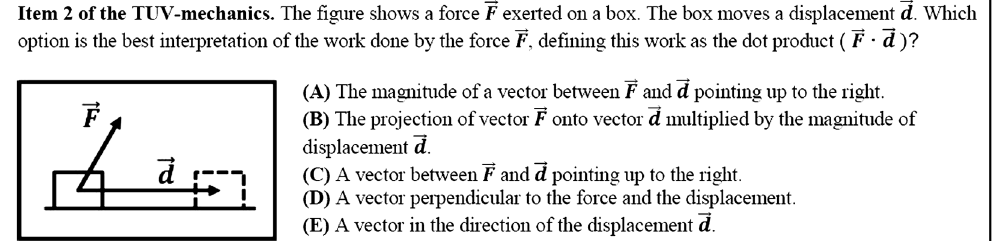
FIG 1. Item 2 of the TUV-12 items no context and the TUV-12 items mechanics that evaluate the geometric interpretation of the dot product as a projection in both contexts used in the first administration. Note that in the second administration we also included at the end of these items the question “ Explain your reasoning.